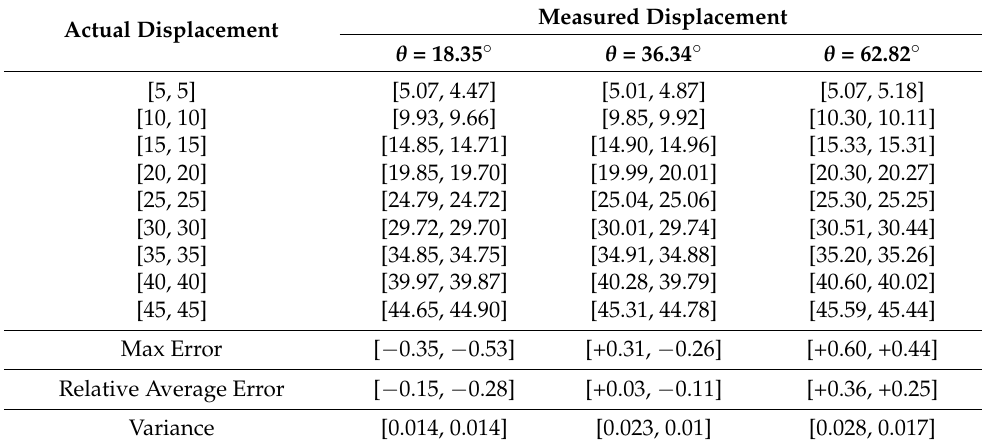
Table 3. Comparison of actual displacement [ r , z ] and measured displacement [ r , z ] when the inter-axis angle is 18.35 ◦ , 36.34 ◦ , and 62.82 ◦ , respectively (unit: mm). Actual